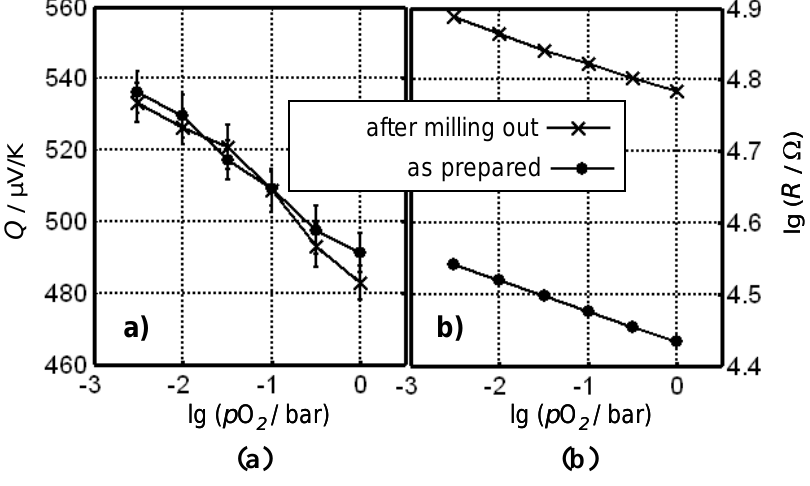
Figure 12. (a) Thermopower and (b) resistance of a thermoelectric gas sensor before and after milling out the sensitive layer as indicated. From